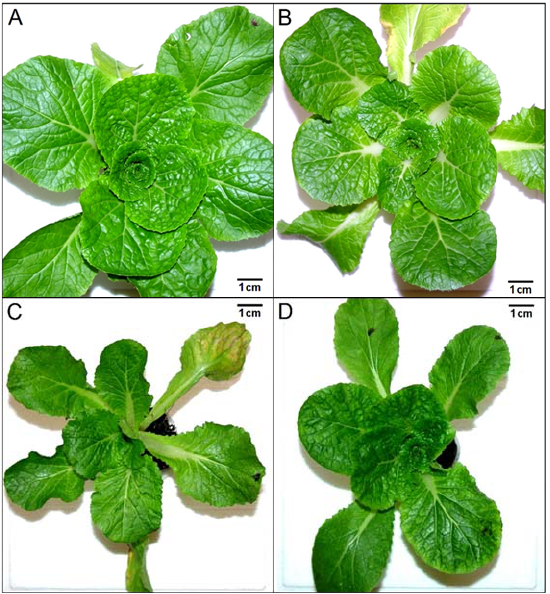
Figure 1. Typical plants of Brassica rapa subsp. pekinensis after 21 days of growth in 100 ‐ ppb O 3 in different light spectra: ( A ) yellow light (sodium lamp, YL), ( B ) white light (WL), ( C ) light with a dominant blue component (WBL) and ( D ) light with a dominant red component (RGBL).